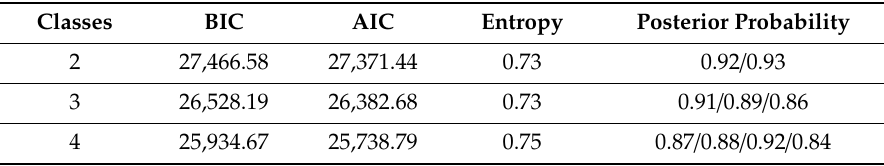
Table 1. Fit indices for trajectories of work life satisfaction.